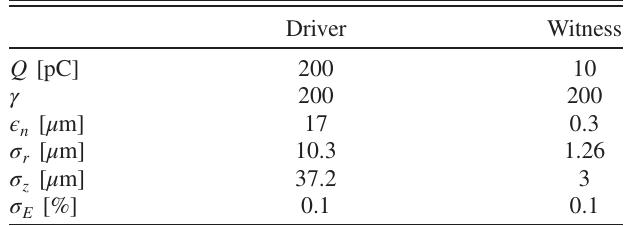
TABLE I. Beam parameters at the injection.